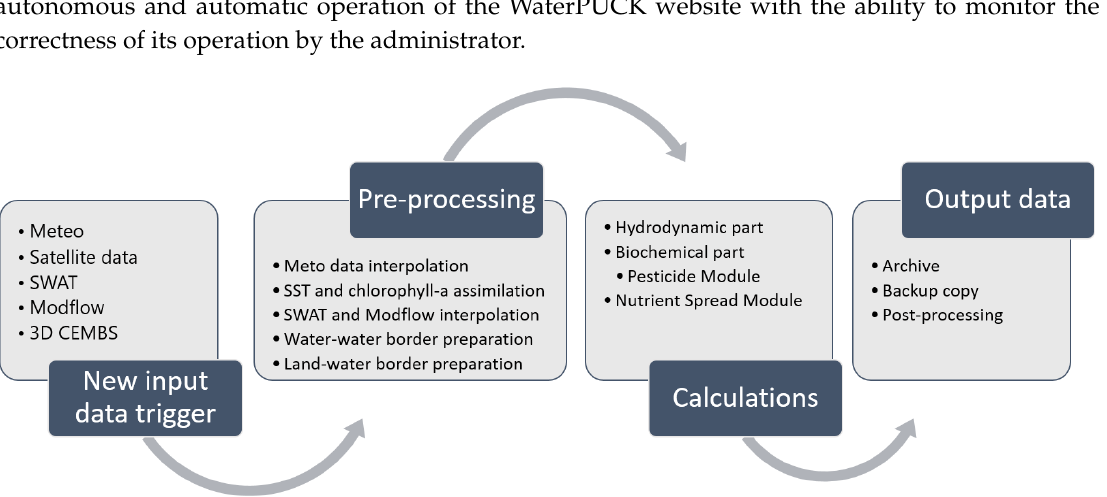
Figure 2. The EcoPuckBay production cycle starts every time new input data (meteo, assimilation, or from SWAT and/or Modflow models)